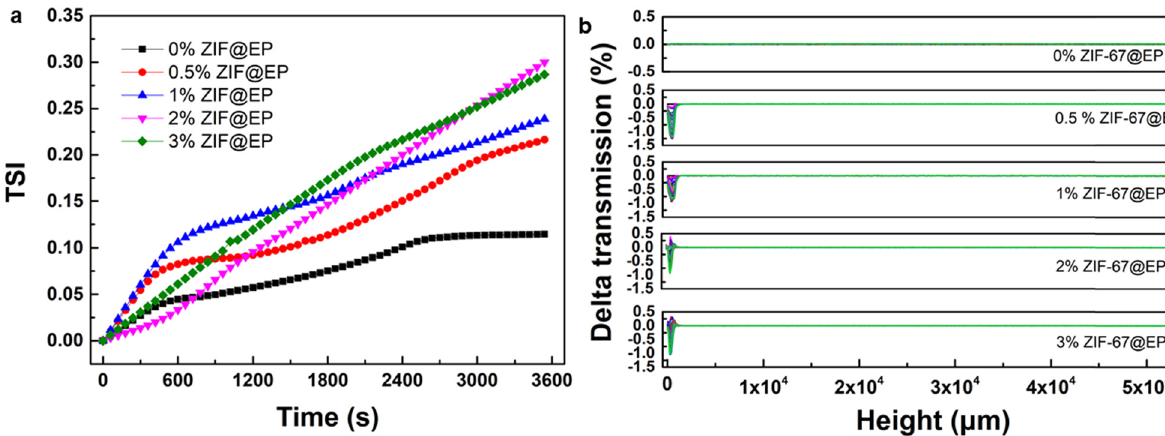
Figure 2: ( a ) TSI plots for composite coatings and ( b ) Δ T plots for composite